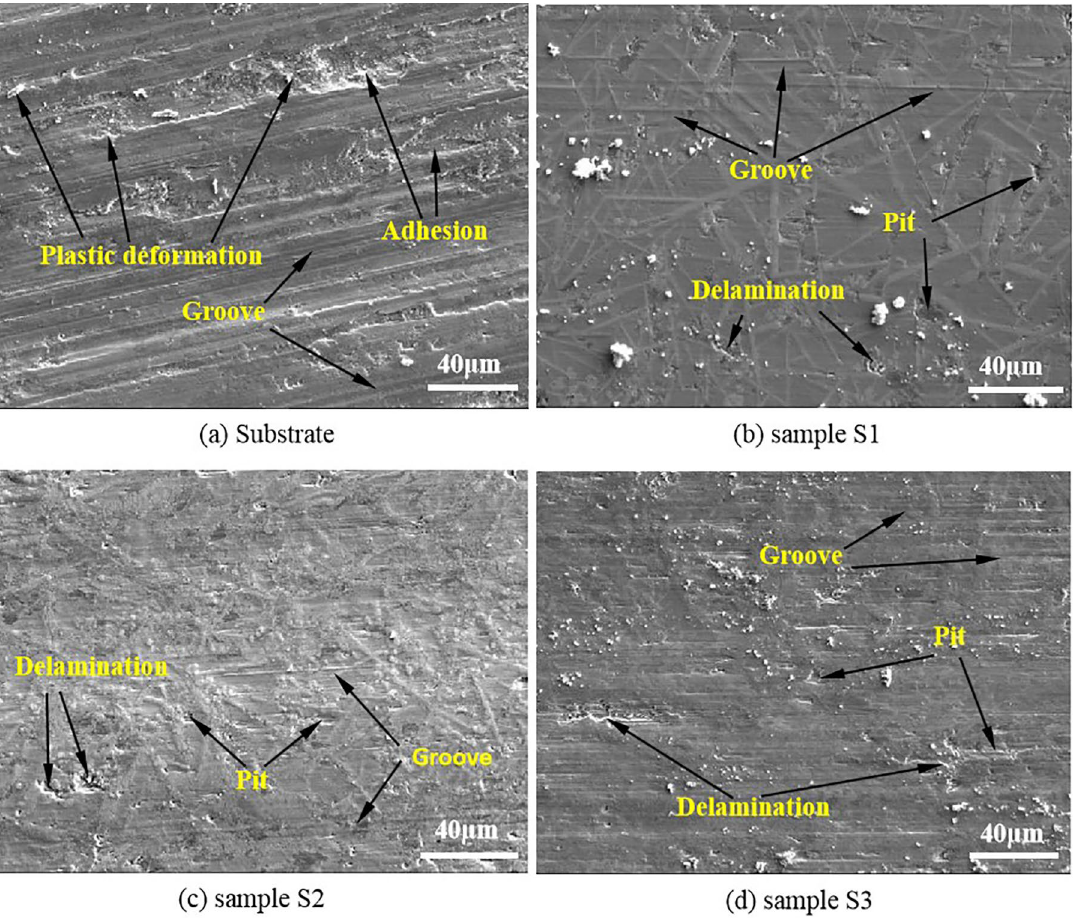
Figure 10. EPMA micrographs of the worn surface morphologies of the coatings and substrate: (a) Substrate; (b)Sample S1; (c) Sample S2; (d) Sample S3. lose their cutting function. Hence, the worn surfaces are smooth and grooves are shallow and narrow. From the